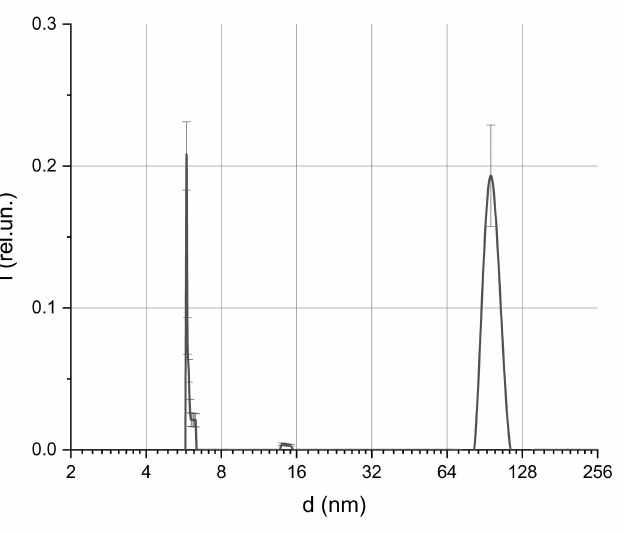
Figure 4. Size distribution of albumin protein in solution with a concentration of 50 mg/mL. The detected particles of 10–30 nm in size corresponded to single nanoparticles of a magnetic fluid. These particles were found in the study of pure MF solutions. Figure 5 presents the sizes of scatterers in MF with a concentration of 1 mg/L. The solution also con- tained larger aggregates with sizes of up to 500 nm, which corresponded to the